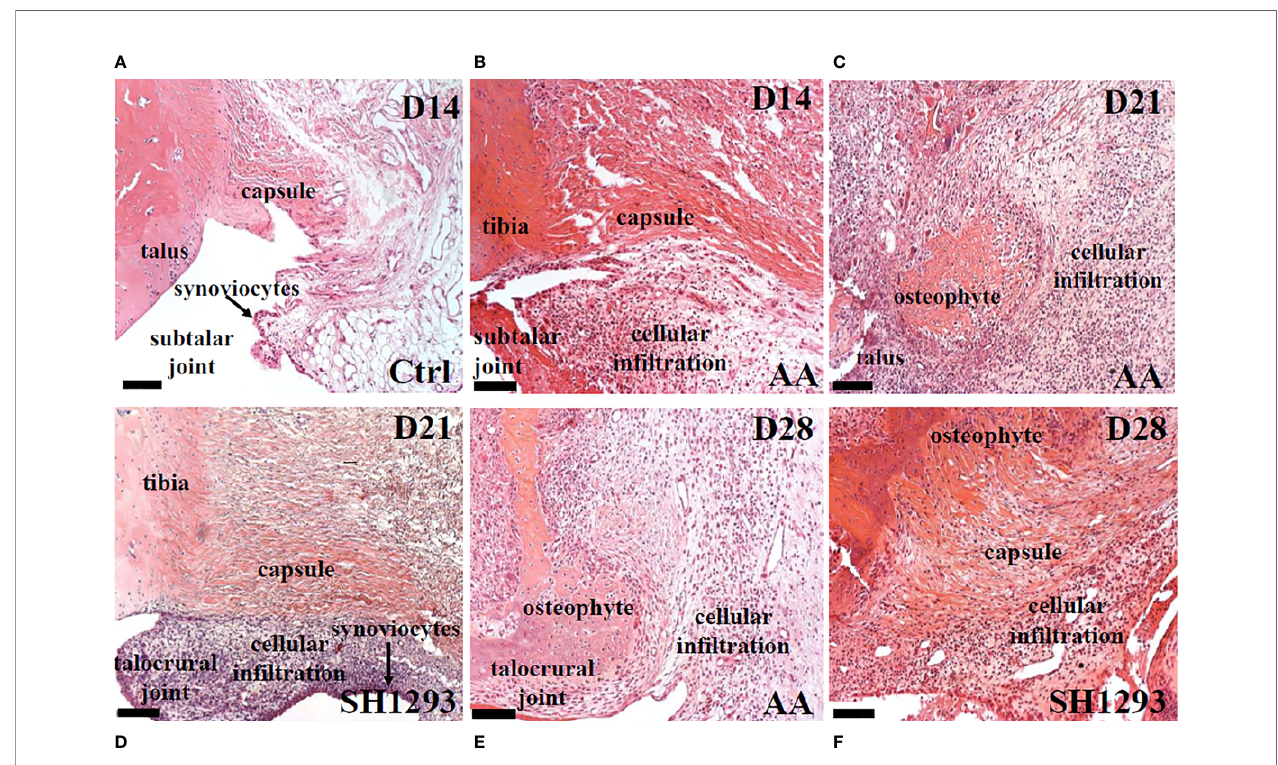
FIGURE 3 | SH1293 Reduced In fl ammatory In fi ltrates in Talus and Subtalar Joint. Representative images of H&E-stained sections of the ankle joint from Ctrl, AA and SH1293 rats. (A) In Ctrl rats, fi brous connective tissue forming the capsule of the subtalar joint was intact and periarticular adipose tissue was a prominent feature. Synoviocytes formed a thin synovial lining between the joint capsule and the joint cavity and was largely devoid of a cellular in fi ltrate. (B) By D14, joints from AA rats revealed that collagen fi bers of the capsule remained intact in the subtalar joint, however, a thickening of the synovial capsule and cellular in fi ltration by leukocytes were apparent. (C) Arthritis progressed in joints from AA rats at D21 as indicated by continued thickening of the synovial membrane, a severe increase in cellular in fi ltration, distal tibial bone resorption and the growth of large areas of osteophyte. (D) In contrast to vehicle treated AA rats at D21, arthritis proceeded more slowly in rats treated with SH1293. In this treatment group, collagen fi bers forming the capsule remained intact, but proliferation of synoviocytes was apparent with a thickening of the synovial membrane and leukocyte in fi ltration. While synovial thickening and leukocyte in fi ltration was present, it was much less than that observed for untreated AA rats. (E) By D28 in vehicle-treated AA rats, disease continued to progress as evident by the extensive distal tibial bone resorption, the presence of large osteophyte formation and increased leukocyte in fi ltration. (F) By D28 in SH1293-treated AA rats, disease continued to progress but at a slower rate than vehicle treated rats. Some distal tibial bone resorption and osteophyte formation was now apparent and a greater leukocyte in fi ltration was observed than at D21 for this treatment group. Calibration bars = 100